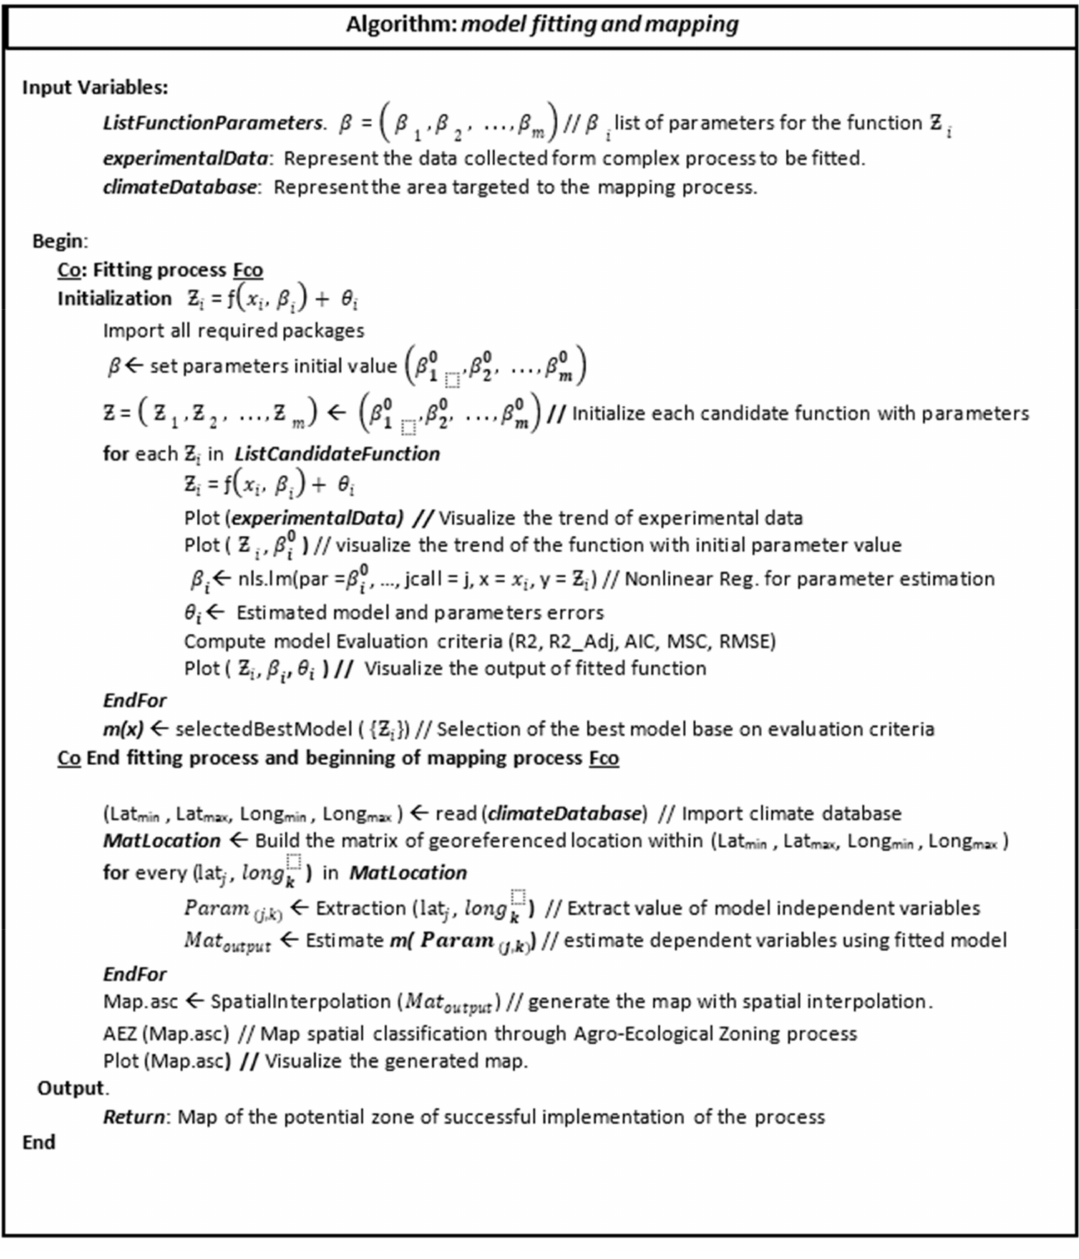
Figure A2. Algorithm: model fitting and mapping